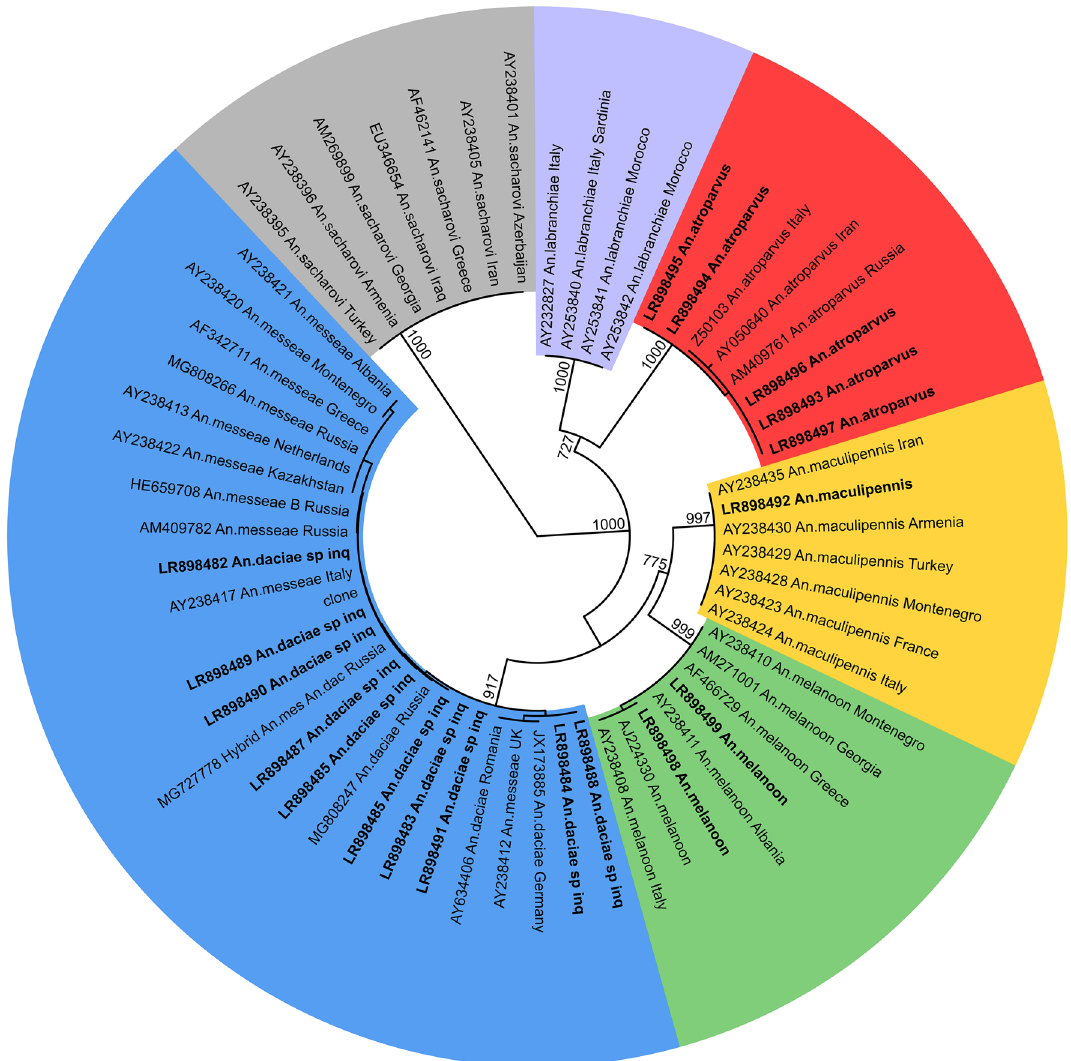
Figure 3. Maximum likelihood tree obtained by ITS2 haplotypes from this work (in bold with EBI accession numbers) and reference sequences from GenBank (accession number reported). Bootstrap values on 1000 replicates reported near the node, only values over 700 are